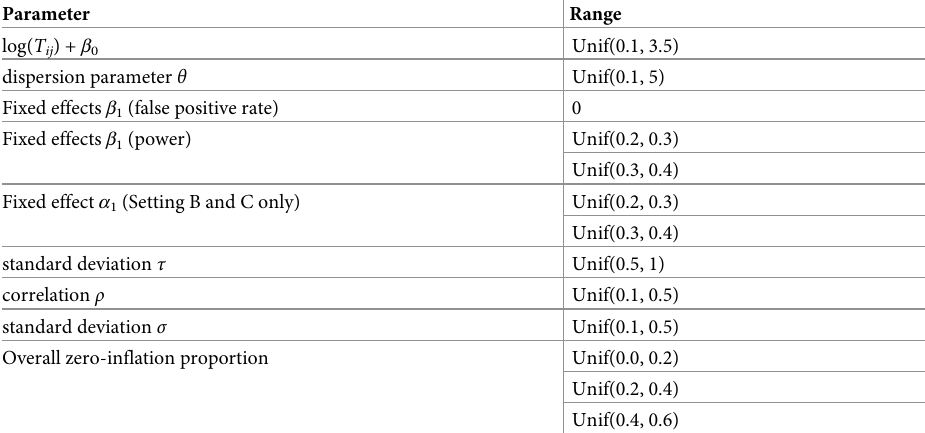
Table 2. Parameter ranges in simulation